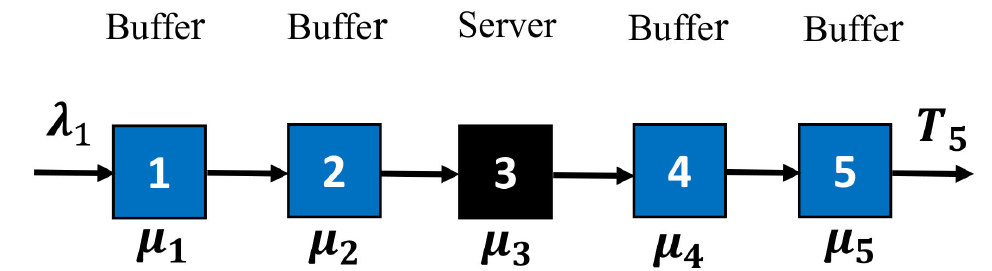
Figure 2. Production line